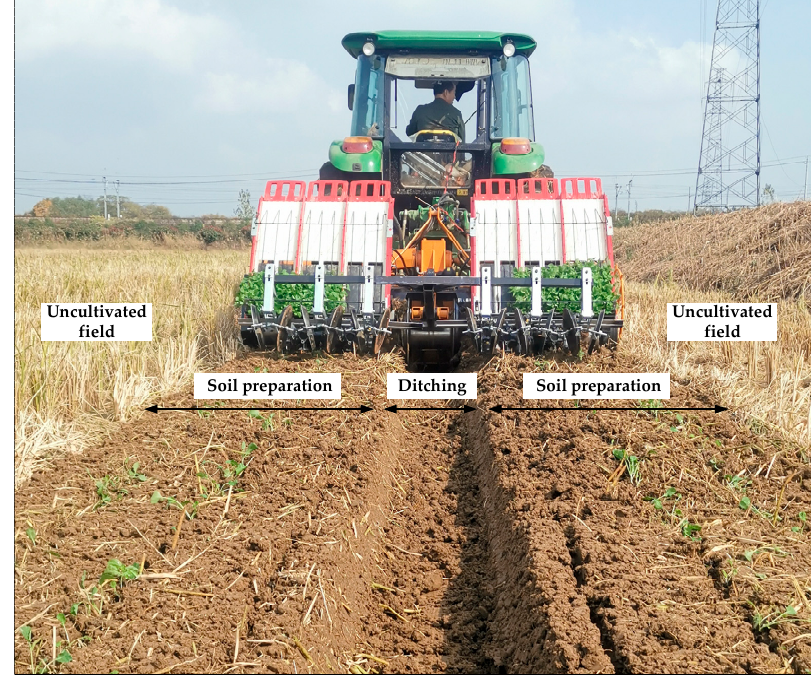
Figure 8. Test equipment and site.